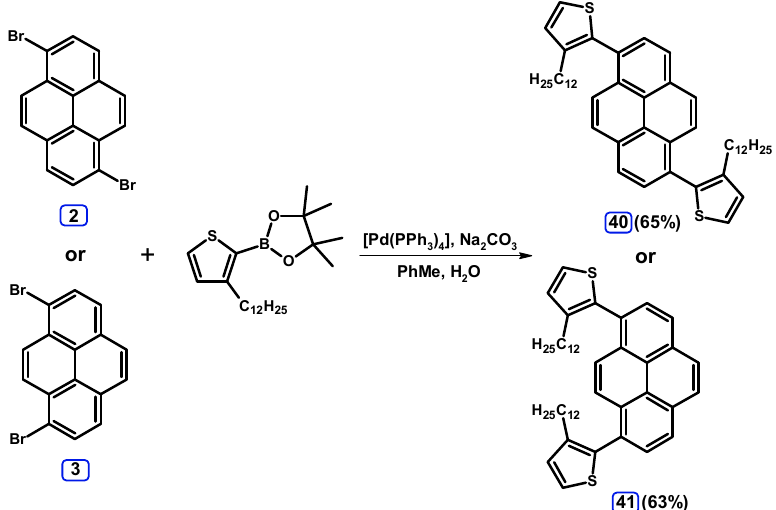
Scheme 23. Synthesis of 1,6- and 1,8-disubstituted pyrenes 38 and 39